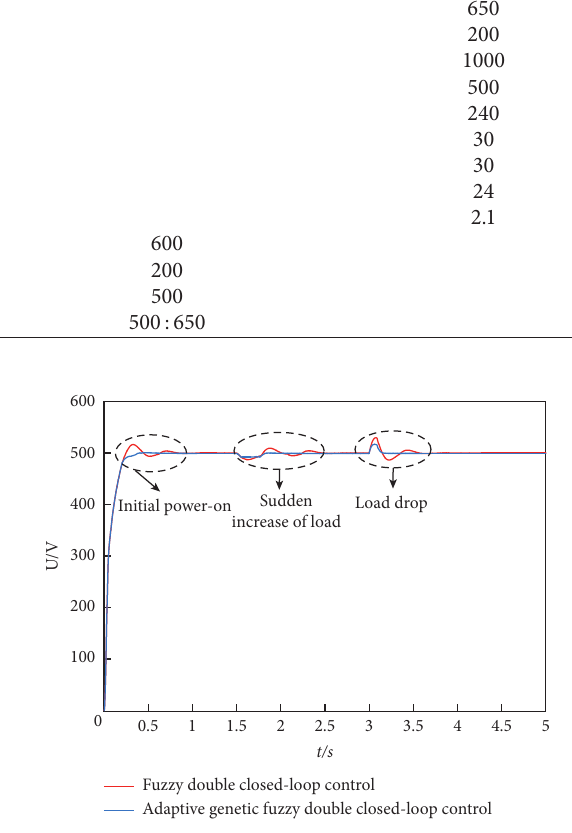
Figure 7: Microgrid 1 bus voltage